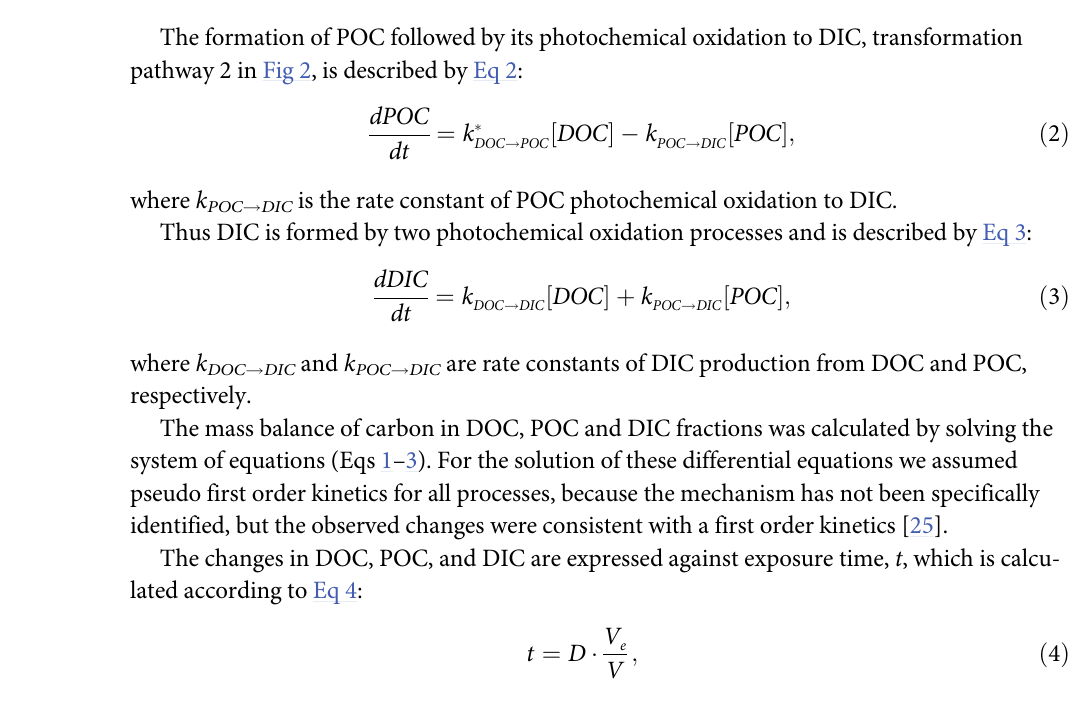
Fig 2. Scheme of possible transformations of organic matter during exposure to irradiation. DOC – dissolved organic carbon, POC – particulate organic carbon, DIC – dissolved inorganic carbon; k DOC ! DIC , k * DOC ! POC , and k POC ! DIC are rate constants of corresponding transformation pathways.